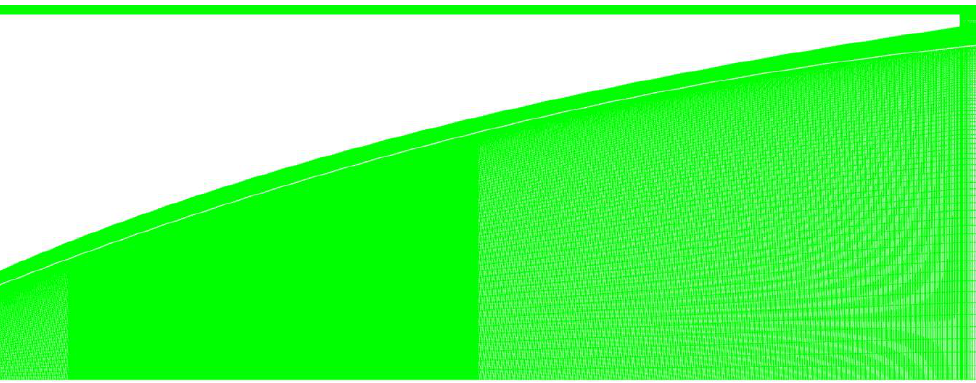
Table 4. Boundary conditions.